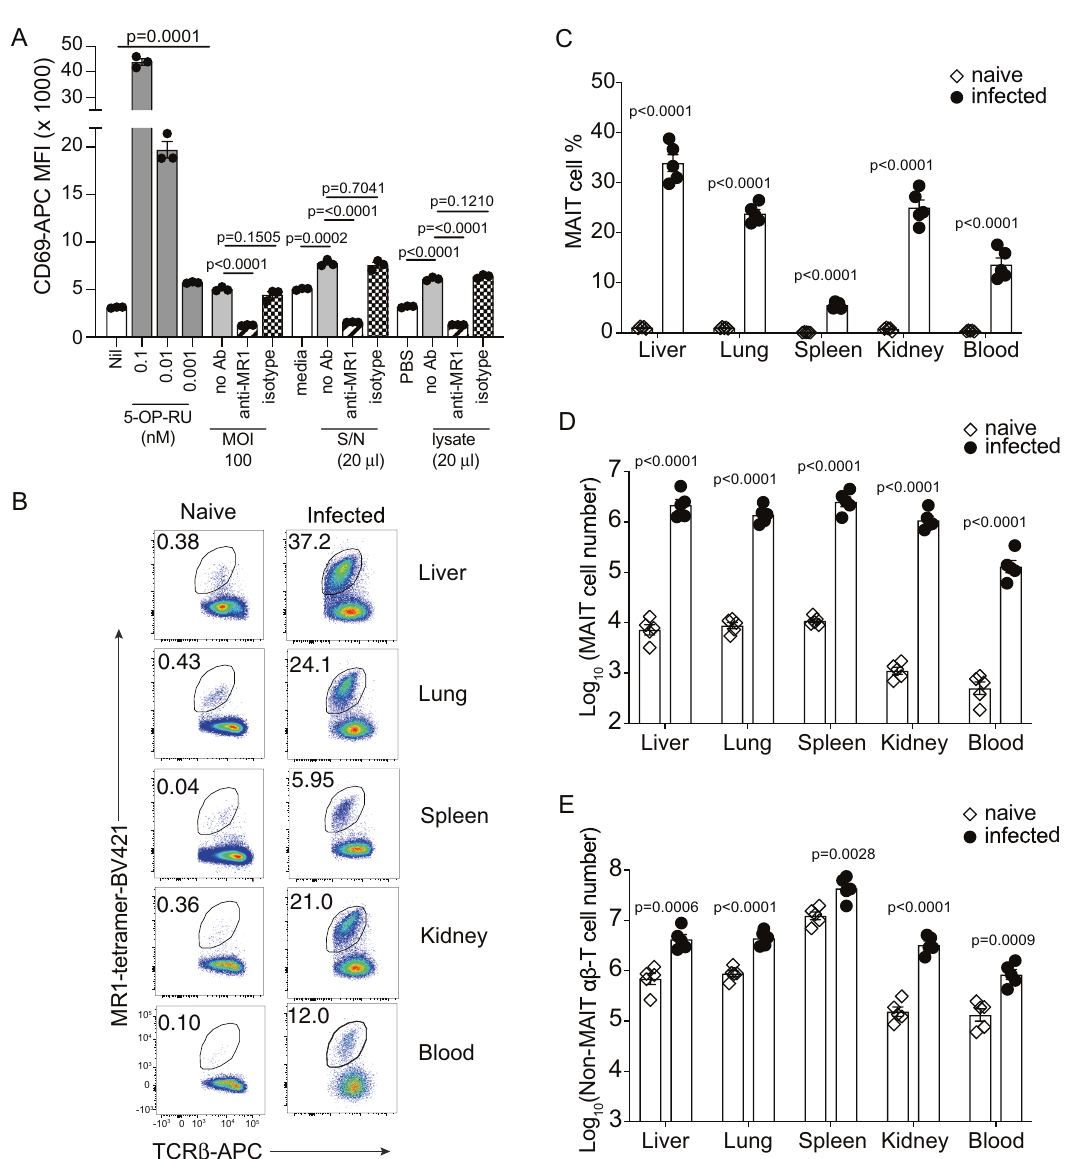
Fig. 1 F. tularensis LVS activates MAIT reporter cells via MR1 in vitro and induces systematic MAIT cell expansion in vivo. A Jurkat.MAIT-AF7 and C1R. MR1 cells were co-incubated for 16 h with indicated amounts of 5-OP-RU, F. tularensis lysate (in PBS), PBS, F. tularensis culture supernatant, or media control (BHI). For infection samples, we co-cultured Jurkat.MAIT-AF7 for 16 h with C1R.MR1 cells that had been infected at the indicated MOI for 4 h, in the presence of gentamicin. Activation was detected by staining with anti-CD69 antibody. Anti-MR1 antibody (26.5) or isotype control (W6/32) was added, as indicated, to C1R.MR1 cells 2 h prior to co-incubation with Jurkat.MAIT cells. Experiment was performed on two separate occasions with similar results. Data show mean fl uorescence intensity (MFI) (mean ± SEM of triplicate wells from one experiment). Statistical tests: unpaired t -test (two-tailed) comparing S/N, lysate, and MOI 100 groups with their respective controls, and one-way ANOVA with Dunnett ’ s multiple comparisons, comparing anti- MR1 and isotype control with unblocked samples. P -values are indicated. B Flow cytometry plots and C MAIT cell percentage in αβ -T cells from the liver, lung, spleen, kidney, and blood (200 μ l) of C57BL/6 mice either uninfected or intravenously infected with 10 4 CFU F. tularensis LVS for 14 days. D , E Absolute numbers of MAIT cells and non-MAIT αβ -T cells, respectively, in the liver, lung, spleen, kidney, and blood (200 μ l) of C57BL/6 mice